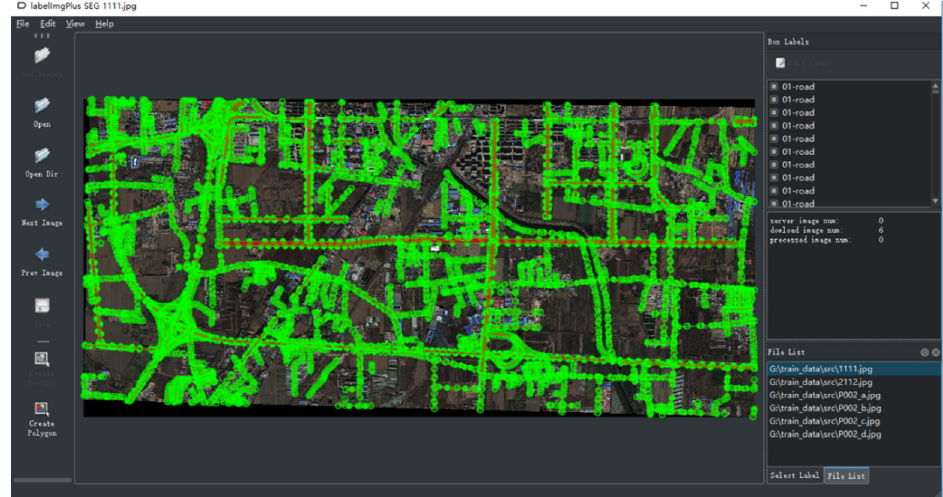
Figure 3. Initial Software Interface and Annotation Results.